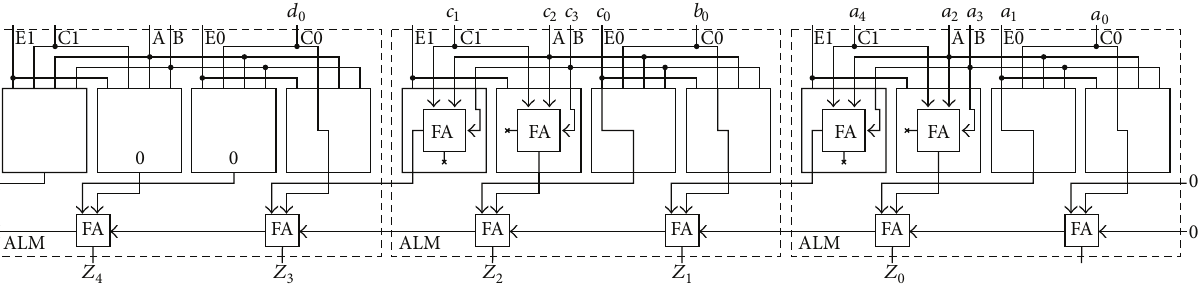
Figure 3: Correct mapping of a (1,4,1,5;5) GPC to Altera Stratix IV requiring six